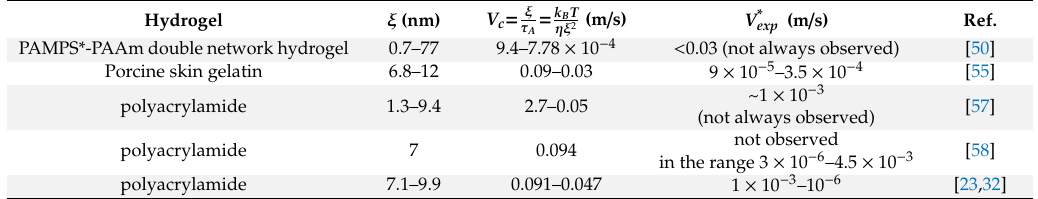
Table 2. Calculated critical velocity ( V c ∼ ξ / τ A ) and observed transition velocity in experiments ( V ∗ ). Calculations at 298 K and for a solvent viscosity of 0.89 mPa · s. Single-network hydrogels, unless indicated. The mesh size was measured in Ref. [57] using Small Angle X-Ray Scattering and in Refs. [23,50,55] using Dynamic Light Scattering. * The abbreviation PAMPS stands for poly(2-acrylamido-2-methylpropanesulfonic acid). / s) V * = k B T / s) ξ (nm) V c = ξ τ ηξ 2 (m exp (m A